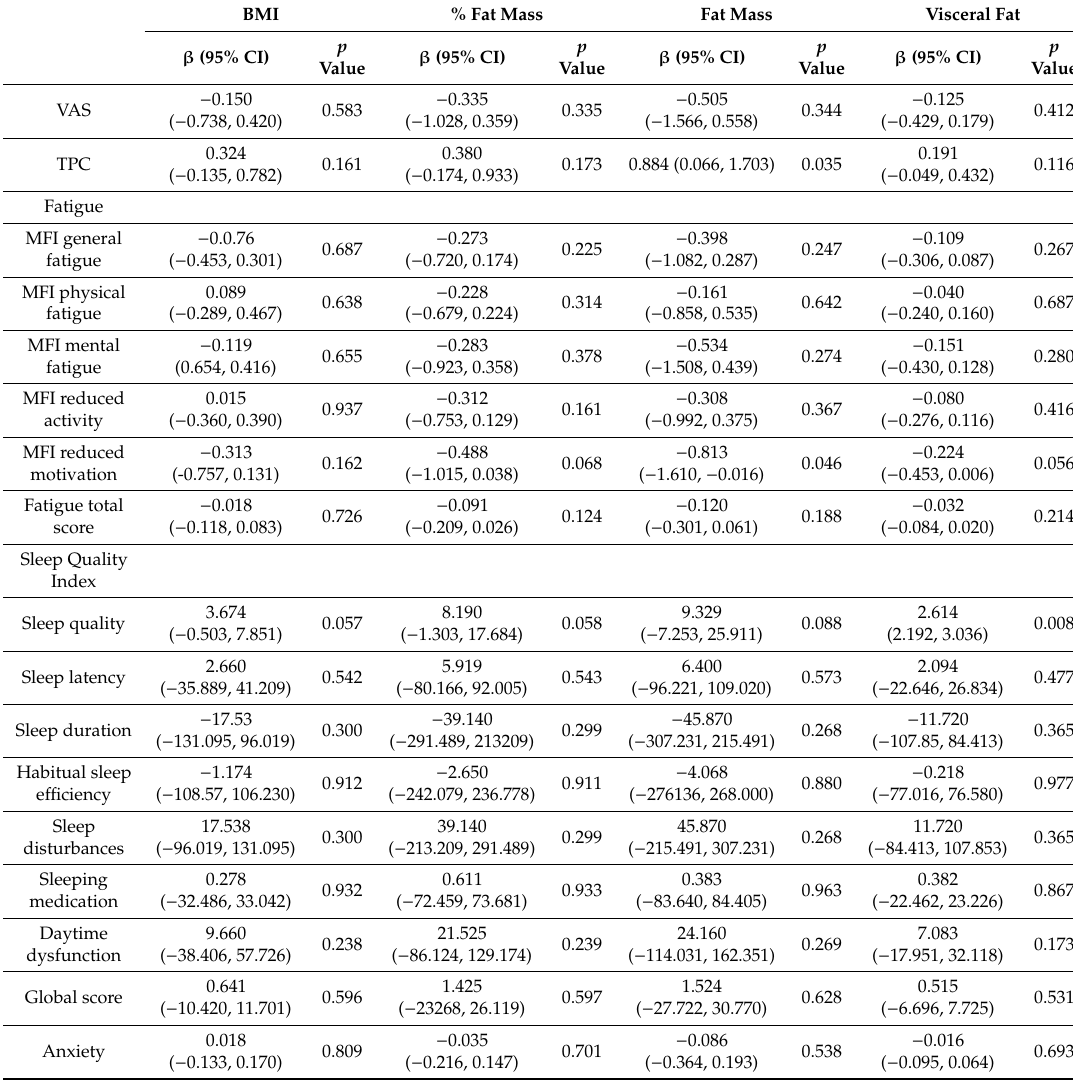
Table 4. Associations among body composition, VAS, TPC, FIQ-R, fatigue, sleep, and anxiety in healthy women. BMI % Fat Mass Fat